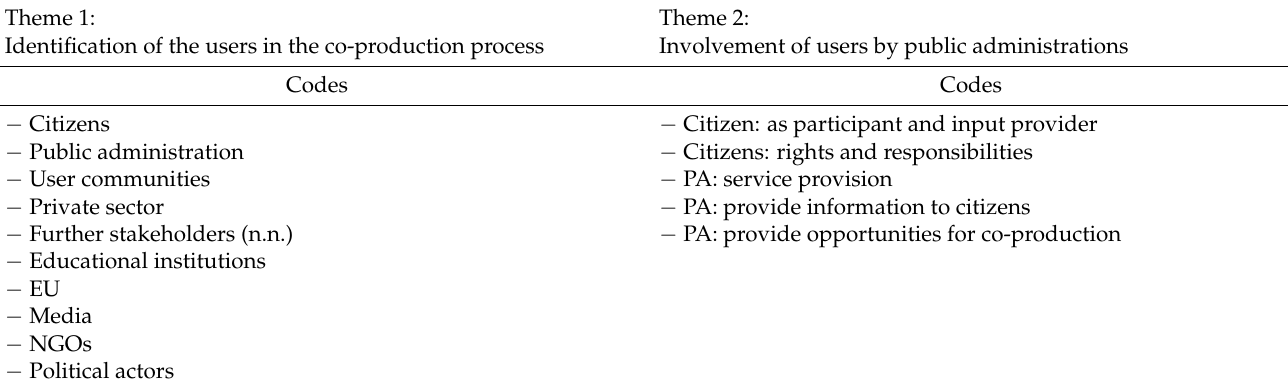
Table 2. Themes and codes used in the